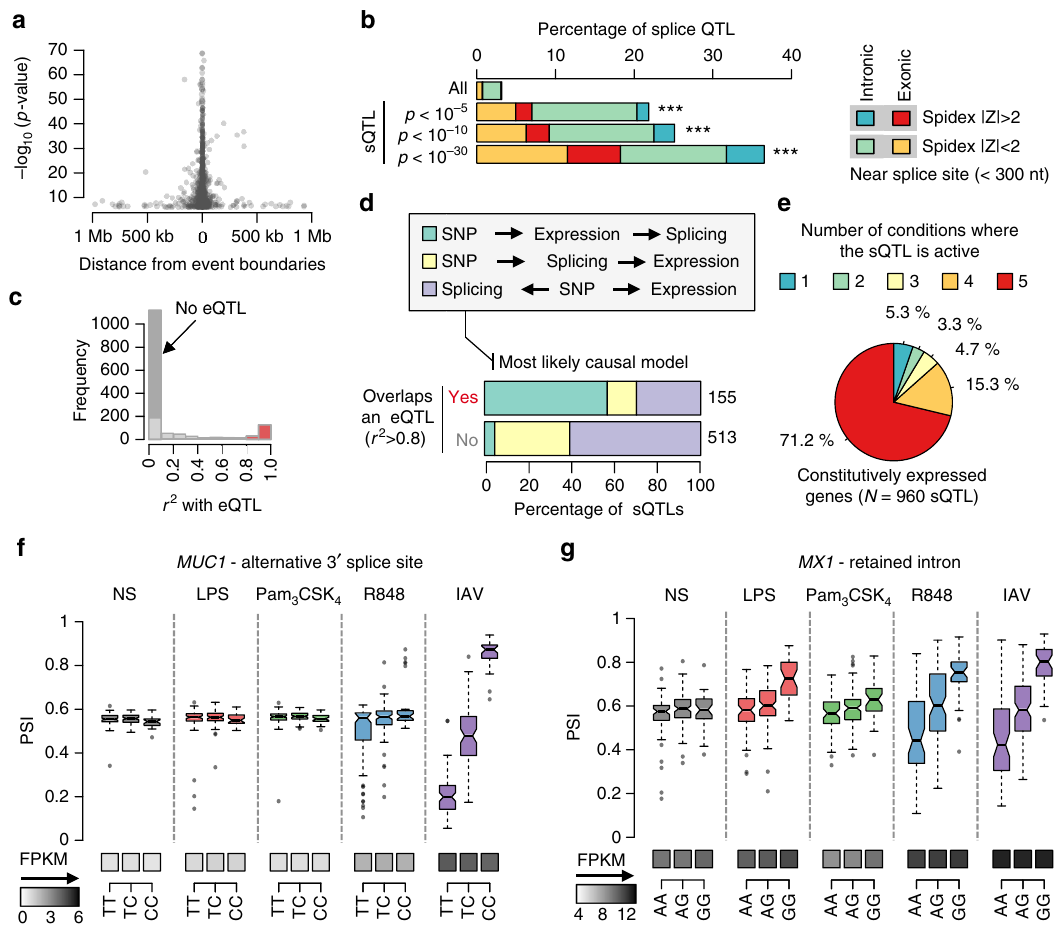
Fig. 4 Genetic regulation of splicing variation in response to immune stimulation. a Distance of splice QTLs (sQTLs) to their associated AS event. Most sQTLs are located in close proximity to their respective AS event. b Enrichment of sQTLs in near-exonic regions and sites predicted to alter splicing by SPIDEX. Twenty percent of sQTLs are located in exonic or intronic regions located <300 nucleotides (nt) apart of a splice site. The enrichment increases with the levels of signi fi cance of sQTLs (***Fisher ’ s p < 1.1 × 10 − 16 ). c Overlap between all sQTLs and eQTLs identi fi ed for the same gene and condition. sQTLs of genes without eQTLs are shown in dark grey, and sQTLs that colocalize with an eQTL ( r 2 > 0.8) are shown in red. d Frequency of inferred causal model among sQTLs associated with gene expression. Causality is shown separately for sQTLs overlapping a cis -eQTL ( r 2 > 0.8), and sQTLs that show marginal associations with gene expression ( p expr < 0.05 in the condition where the sQTL is the strongest) but do not overlap an eQTL. For each group, the total number of sQTLs is reported. e Sharing of sQTLs across conditions. For the 960 sQTLs where the corresponding gene is expressed across all conditions, the pie chart represents the number of conditions where the sQTL is active. f Example of a context-speci fi c sQTL that manifests only upon IAV infection because the expression of the corresponding MUC1 gene is restricted to the IAV condition. For each genotype and condition, the boxplots show the distribution of PSI (centre line, median; box limits, upper and lower quartiles; whiskers, 1.5× interquartile range; points, outliers). For each genotype and conditions, grey squares indicate FPKM levels (darker shade = higher gene expression). g Response sQTL (rsQTL) leading to differential intron retention in the 5 ′ -UTR region of the MX1 gene in response to LPS, R848 and IAV (boxplots drawn as previously). f , g Boxplots are coloured according to the condition of stimulation. Source data are provided as a Source Data fi